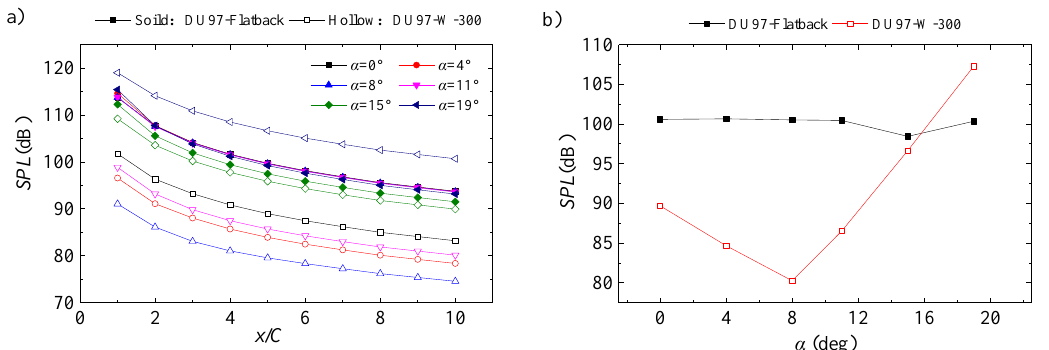
Figure 18. Total SPL distribution of the airfoils: ( a ) The average value of SPL in four directions. ( b ) The total SPL.